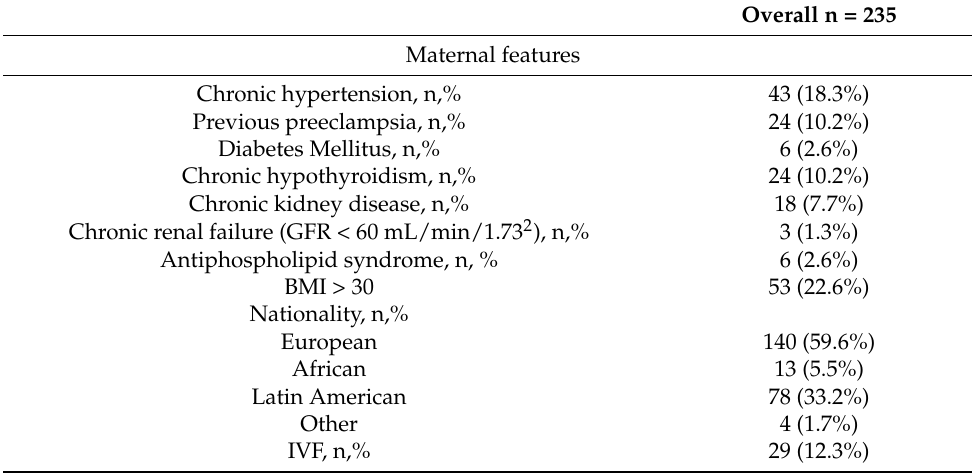
Table 2. Description of the clinical variables in cases of severe preeclampsia. Variables are